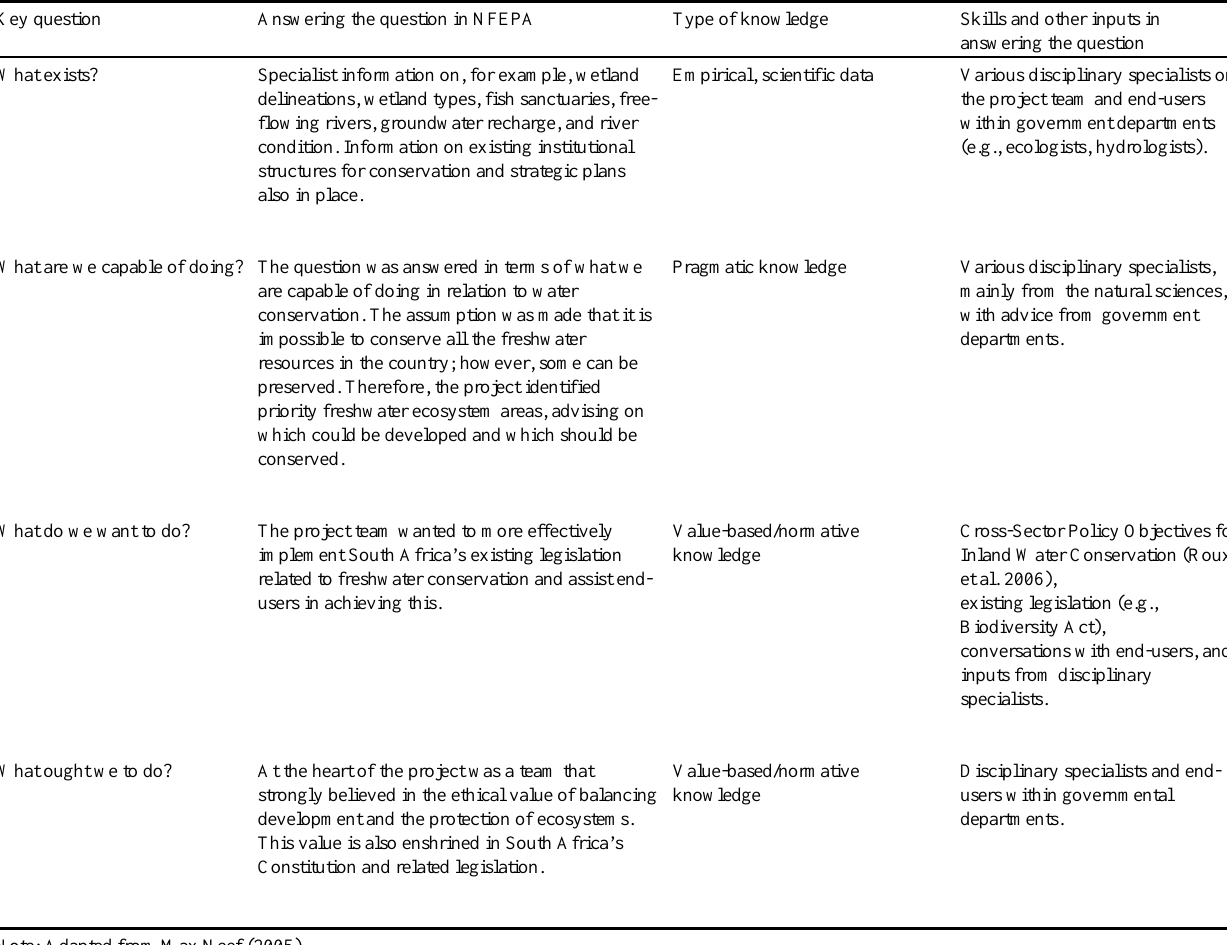
Table 2 . Transdisciplinarity and the NFEPA